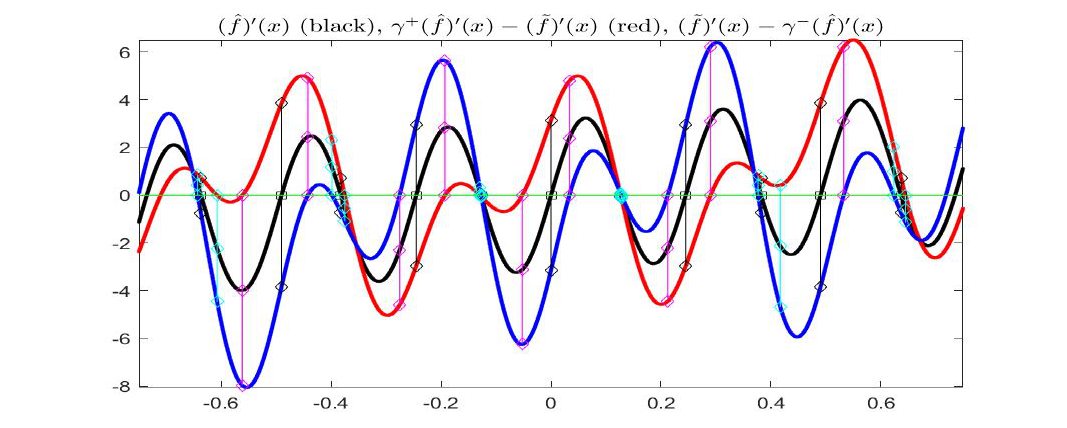
Figure 16. Complete Example: function F ( x ) is represented in interval form, and all the zeros x i of (cid:98) f ( x ) are classified as min or max points; all the efficient regions are delimited by vertical lines (cyan-colored for six max points and magenta for five min points). The black vertical lines are the intervals F ( x i ) , i = 1,2, . . . ,11.